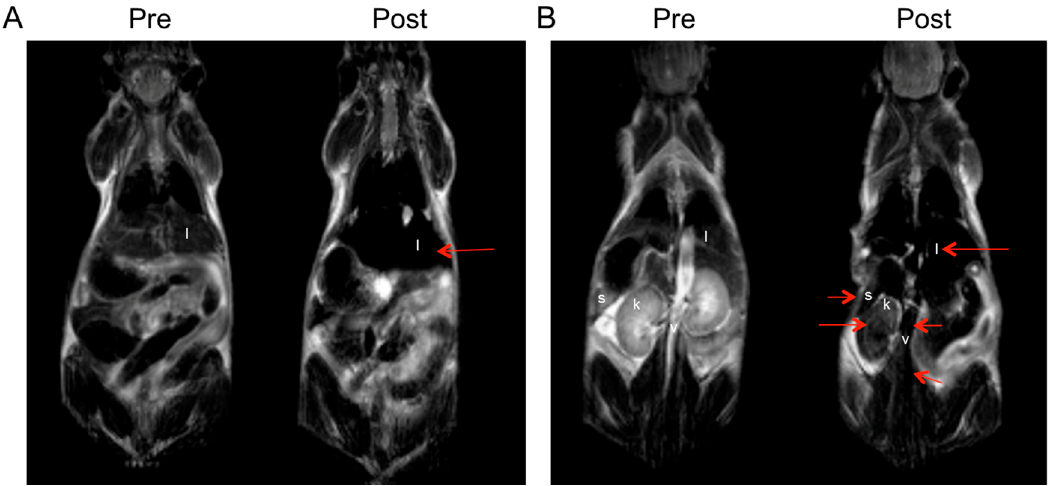
Figure 6. In vivo T2-weighted MRI scans of LHRH-MNPs injected into non-tumor-bearing nude mice (no tumors), showing a darkening effect. ( A ) Image slice depth highlighting the liver (l). ( B ) Image slice depth highlighting the kidney (k), liver (l), spleen (s) and major blood vessels (v).